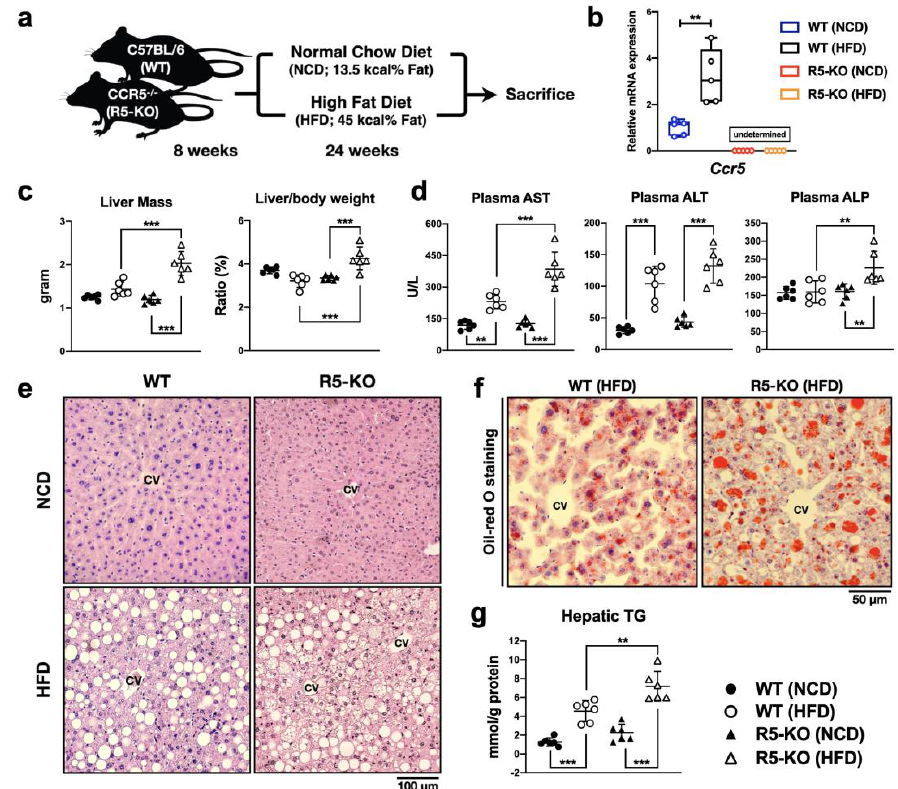
Figure 1. Global CCR5 deficiency exacerbates liver damage and steatosis in NAFLD. ( a ) A schematic diagram of animal and dietary model. ( b ) Hepatic Ccr5 mRNA level was detected by real-time PCR. Relative expression was normalized to 36b4 reference gene (n = 4 – 6). ( c ) Individual liver mass and body weight were measured and the ratio was calculated (n = 6). ( d ) Plasma concentrations of AST, ALT, and ALP were determined (n = 6). ( e ) Representative liver section images of hematoxylin and eosin staining. Positions of central vein (cv) are labeled. ( f ) Representative liver section images of Oil-red O staining. ( g ) Hepatic triglyceride concentrations were determined by colorimetric assay (n = 6). Representative and quantified results (means ± SD) are shown for the indicated number of mice. **, p < 0.005; ***, p < 0.001.